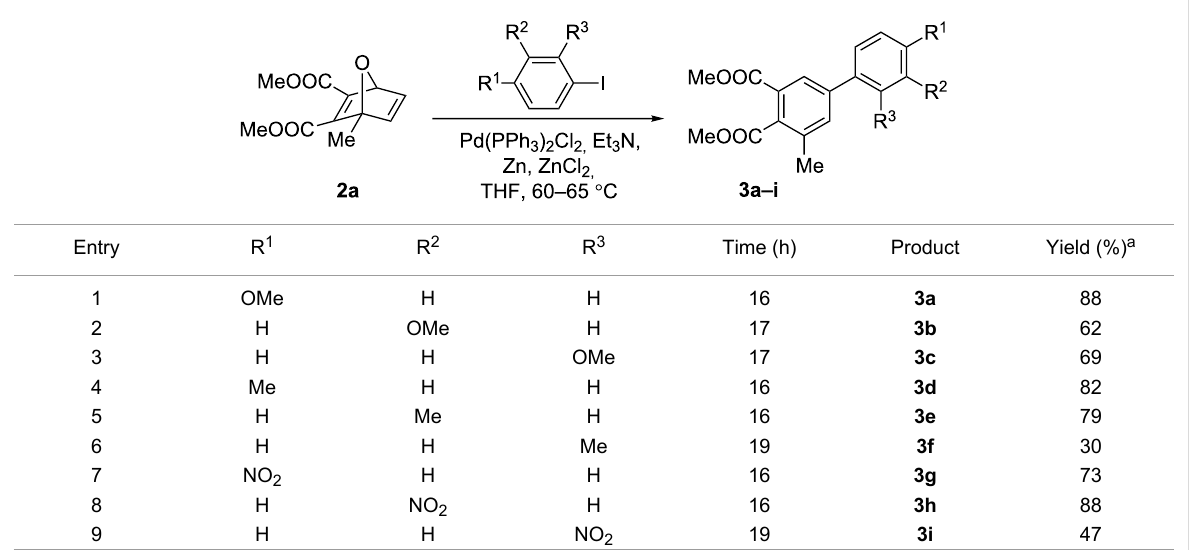
Table 2: Effect of aryl iodide substitution on the ring-opening of oxanorbornadiene.